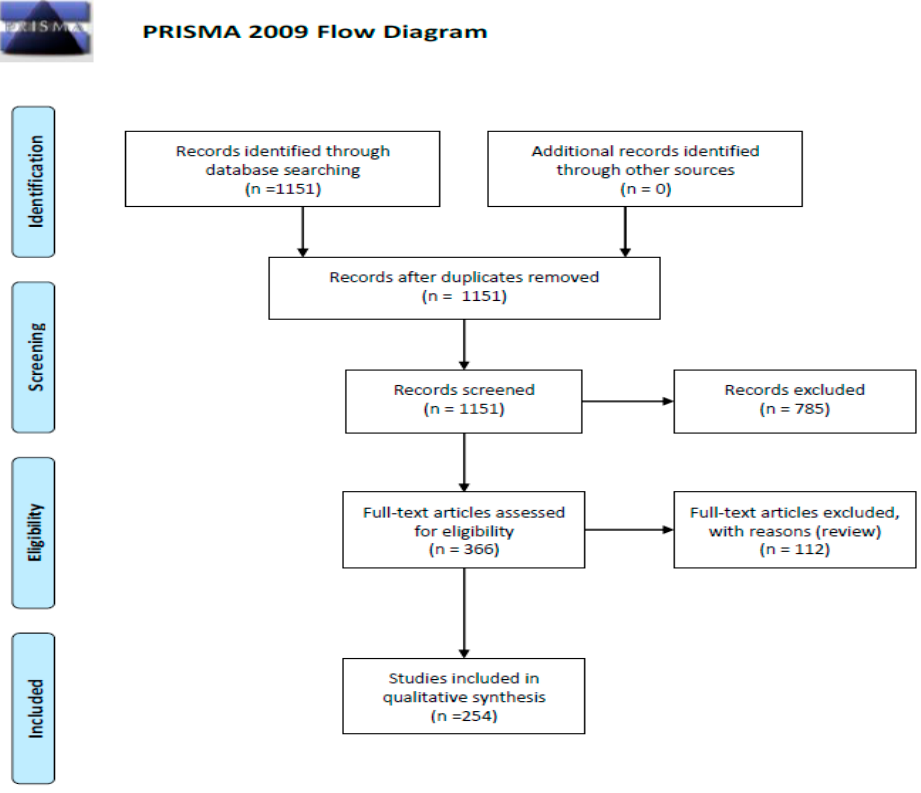
Figure 1. Schematic illustration of articles included in the review manuscript [3].